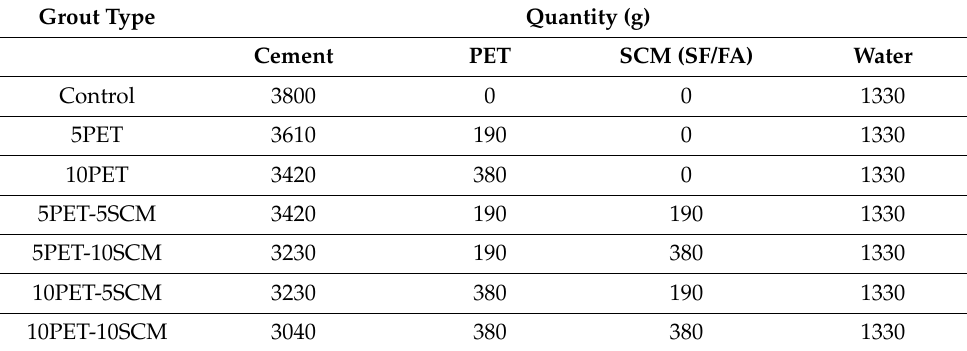
Table 2. Mixed proportion of grouts containing PET and